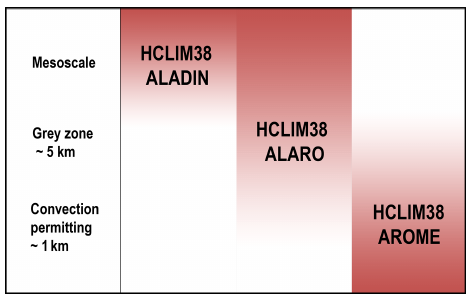
Figure 1. Intended horizontal grid resolutions for the three model configurations available in HCLIM38 (based on Termonia et al.,